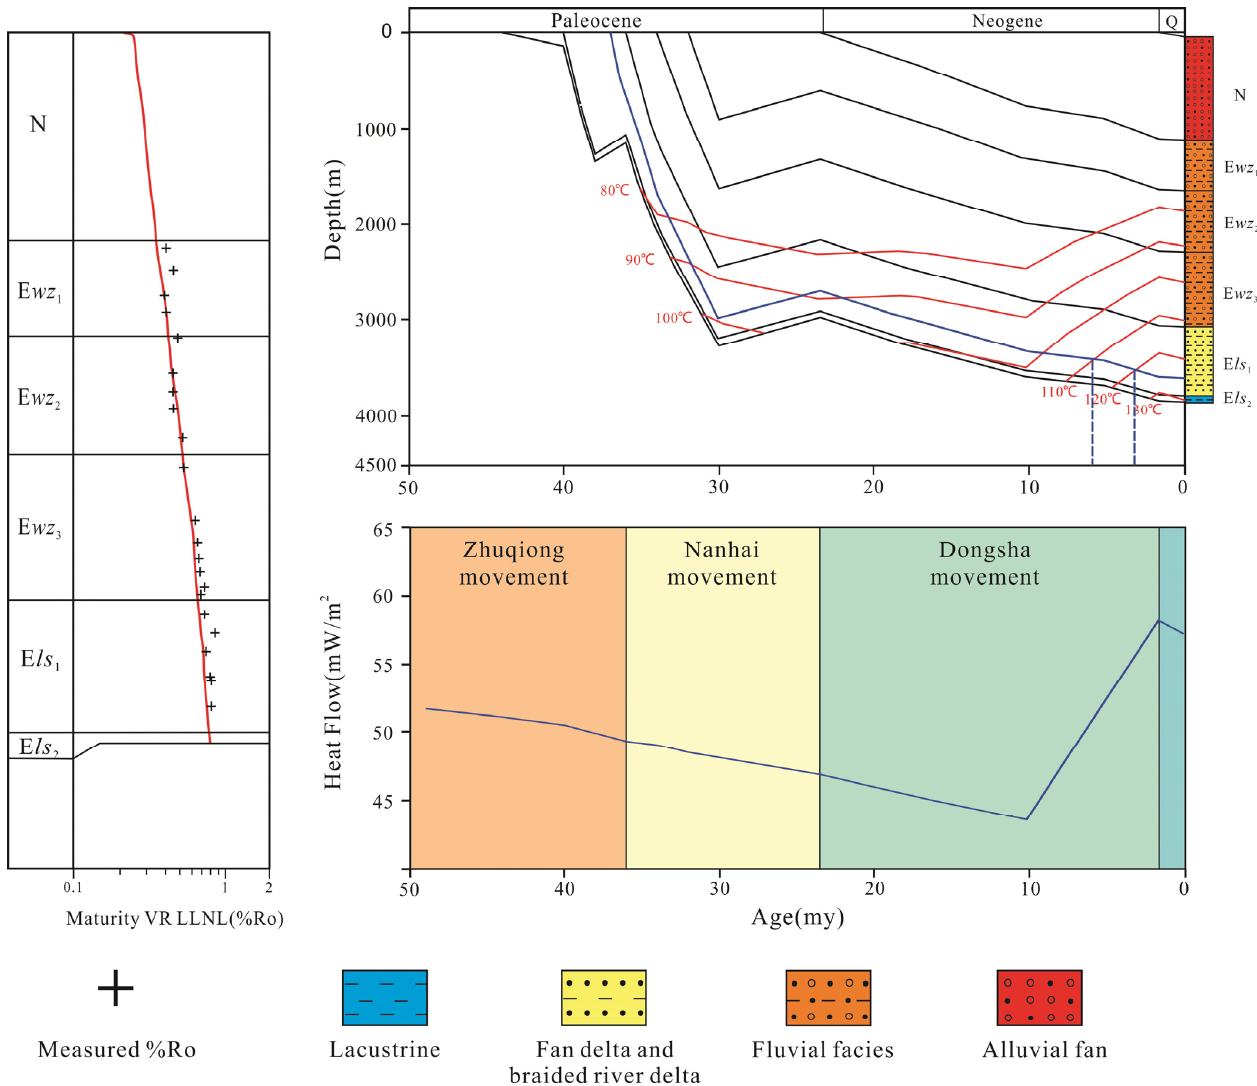
Figure 11. Reconstructed paleo-heat flow model, stratigraphic, burial, and thermal history of the Well Y11.